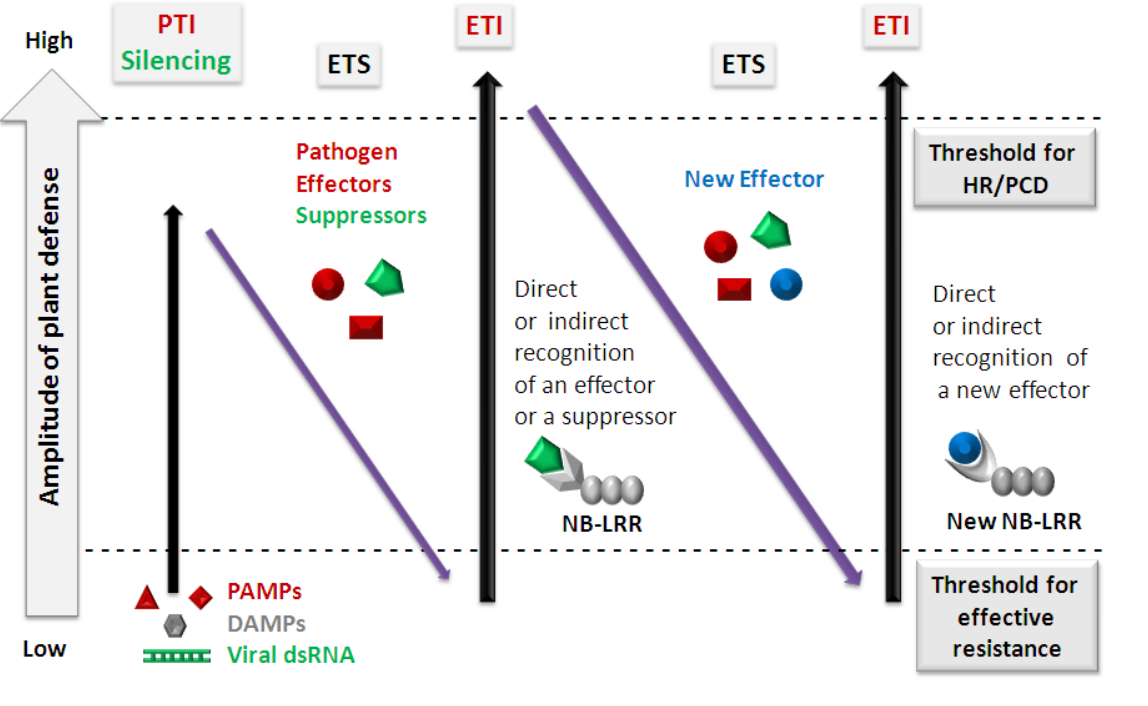
Figure 1. Zig-zag model for evolution of innate immunity- and silencing-based plant defense against viral and non-viral pathogens (adopted and extended from Jones and Dangl 2006 [10]). The ultimate amplitude of disease resistance or susceptibility is proportional